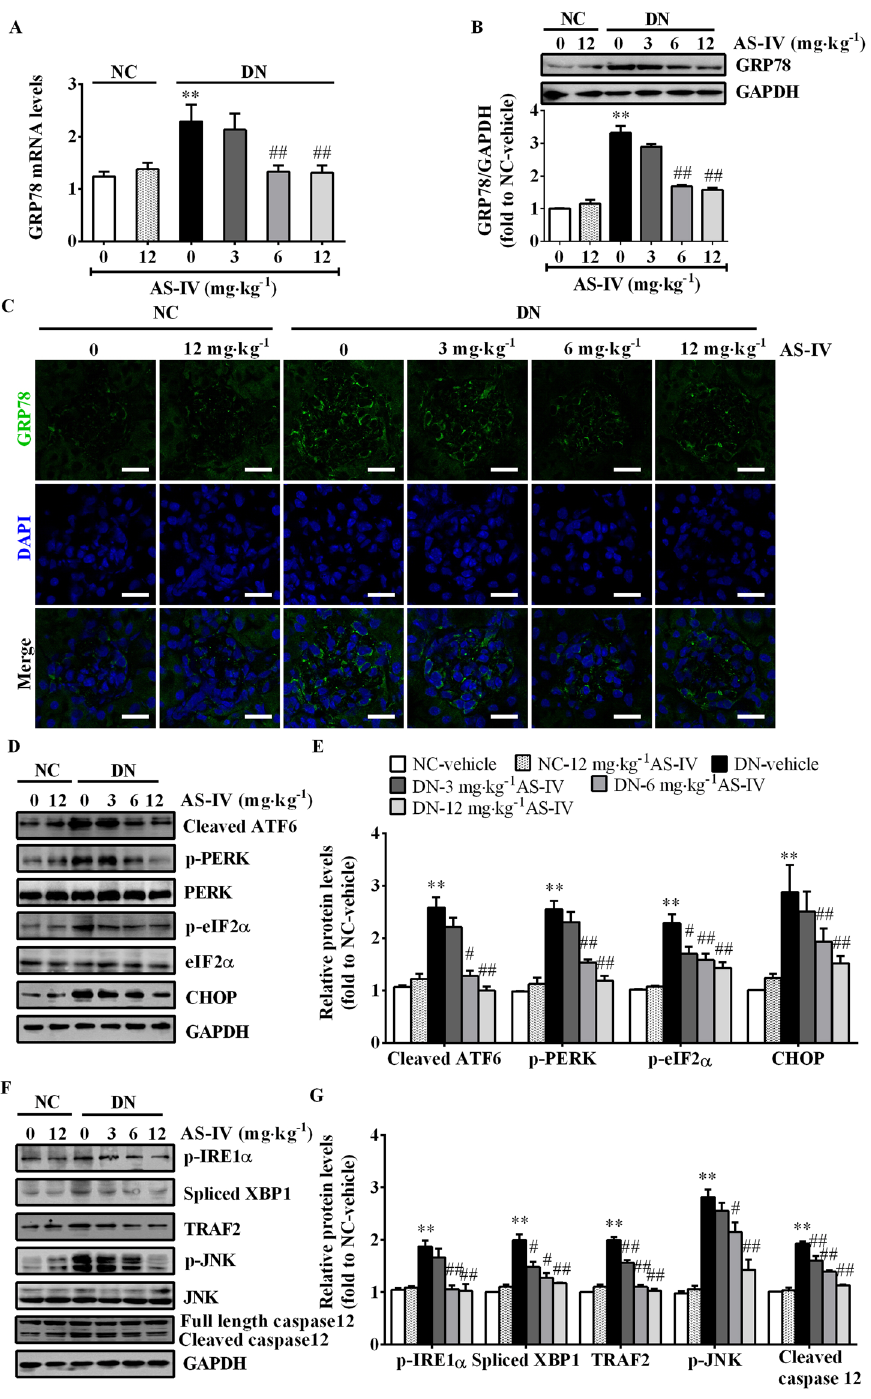
Figure 2. AS-IV repressed ER stress and ER stress-mediated apoptotic pathway in the kidney cortex of STZ- induced diabetic mice. ( A ) qRT-PCR analysis of GRP78 mRNA levels in each group. ( B ) Western blot analysis of GRP78 protein expression in the kidney cortex lysates from each group. ( C ) Immunofluorescence staining for GRP78 expression in each group. Scale bars, 20 μ m. ( D , E ) Western blot analyses ( D ) and densitometric quantification ( E ) of cleaved ATF6, p-PERK, p-eIF2 α and CHOP expression in total lysates of kidney cortex from each group. ( F and G ) Representative immunoblots ( F ) and densitometric quantification ( G ) of p-IRE1 α , spliced XBP1, TNF receptor associated factor 2 (TRAF2), p-JNK and caspase 12 expression in total lysates of kidney cortex from each group. The original blots for panel B, D and F were presented in Supplementary Figure S3. Data are expressed as mean ± SEM. n = 4–6 per group. * P < 0.05, ** P < 0.01 compared to NC-vehicle group; # P < 0.05, ## P < 0.01 compared to DN-vehicle group. One-way ANOVA and Newman-Keuls multiple comparisons test ( A , B , E , G ). NC, non-diabetic control. DN, diabetic